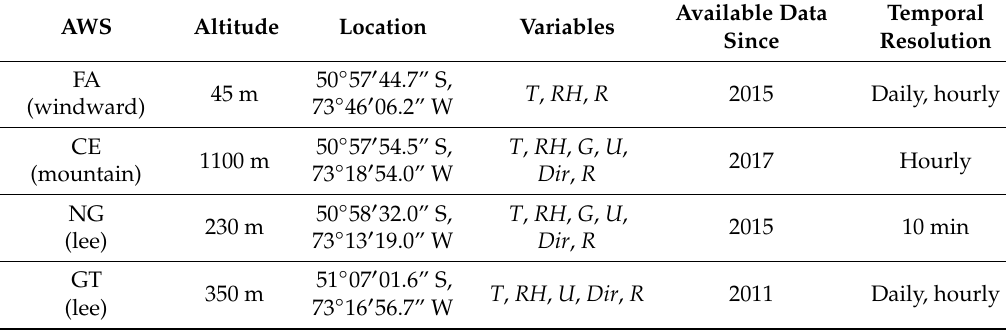
Table 1. Automatic weather stations (AWSs) and their locations, measured variables (air temperature T , relative humidity RH , global (total incoming shortwave) radiation G , wind speed U , wind direction Dir and precipitation R ) and recording